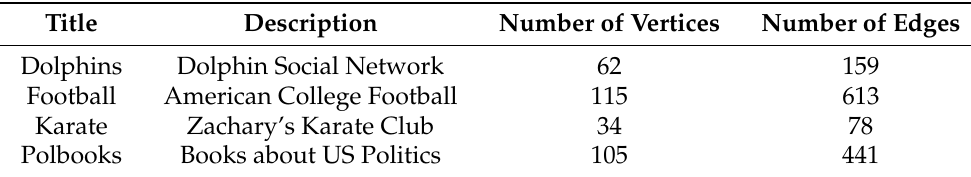
Table 1. Summary of Graphs.